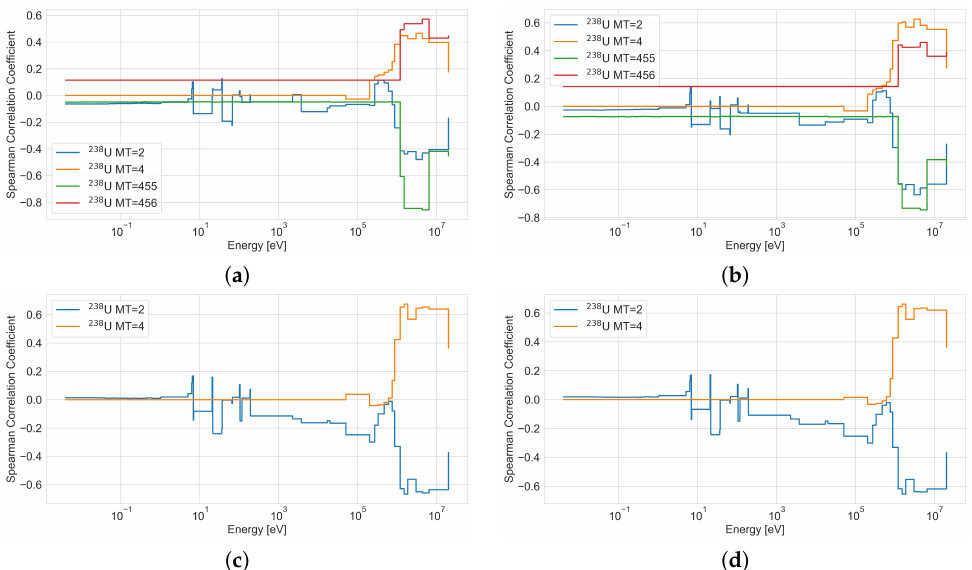
Figure 22. Statistically significant cross-sections Spearman correlation coefficients for ( a ) ρ in , ( b ) P max ( c ) T max and ( d ) H max fc f